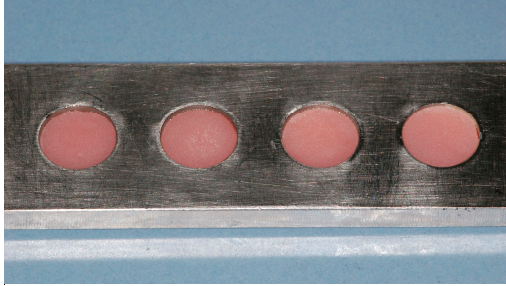
Figure 3. Template for coating the specimens with acetic CS solution.